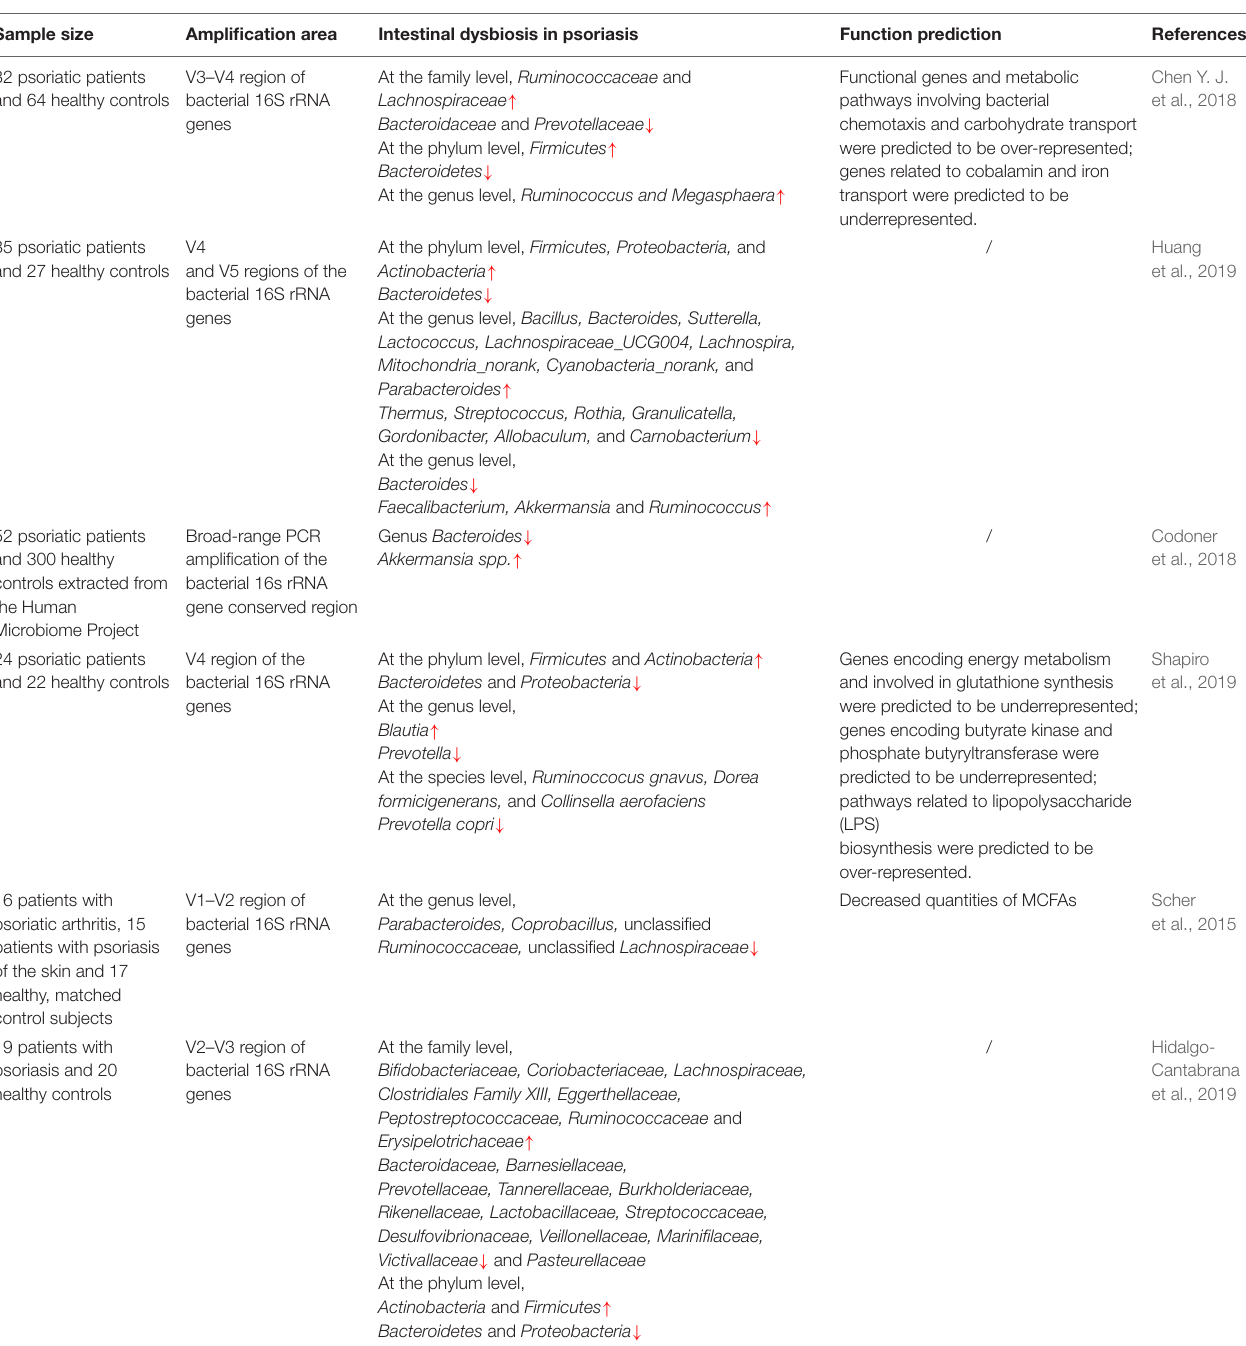
TABLE 2 | Reported intestinal dysbiosis in